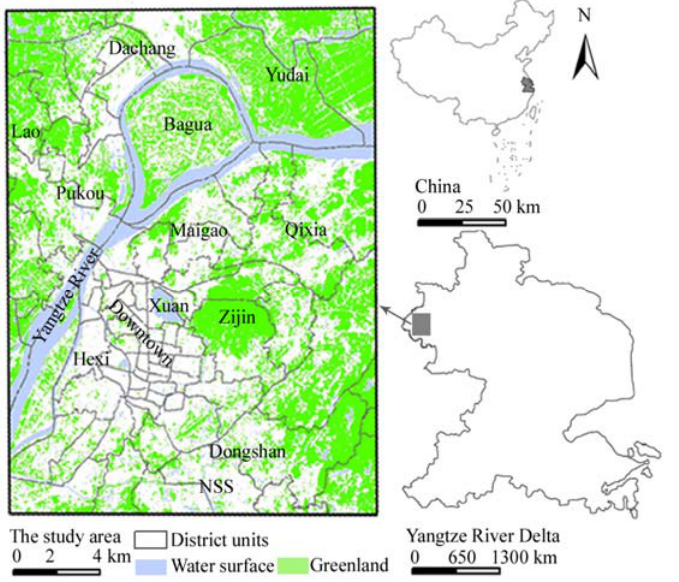
Figure 1. The study area and greenery